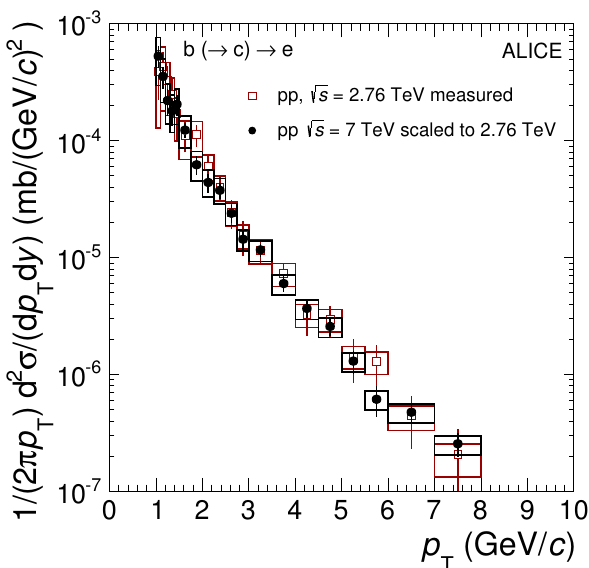
p s = 2.76 TeV obtained p s = 7 TeV in comparison